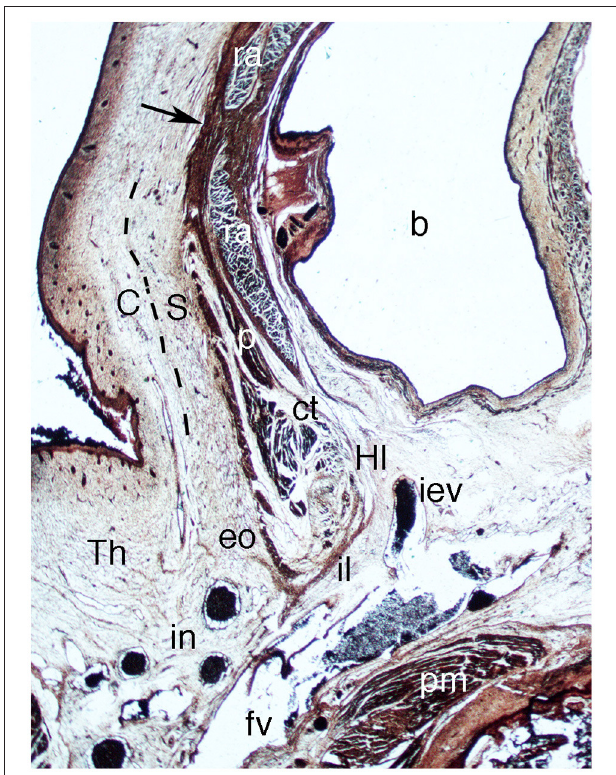
FIGURE 11 | Sagittal section of the abdomen in fetus F-110 (15th week). Azan staining (1X). b, bladder; C, Camper’s fascia; ct, common tendon; eo, external oblique muscle; fv, femoral vein; Hl, Hesselbach’s ligament; iev, inferior epigastric vein; il, inguinal ligament; in, inguinal nodes; p, pyramidalis muscle; pm, pectineus muscle; ra, rectus abdominis; S, Scarpa’s fascia; Th, thigh. Arrow, aponeurotic